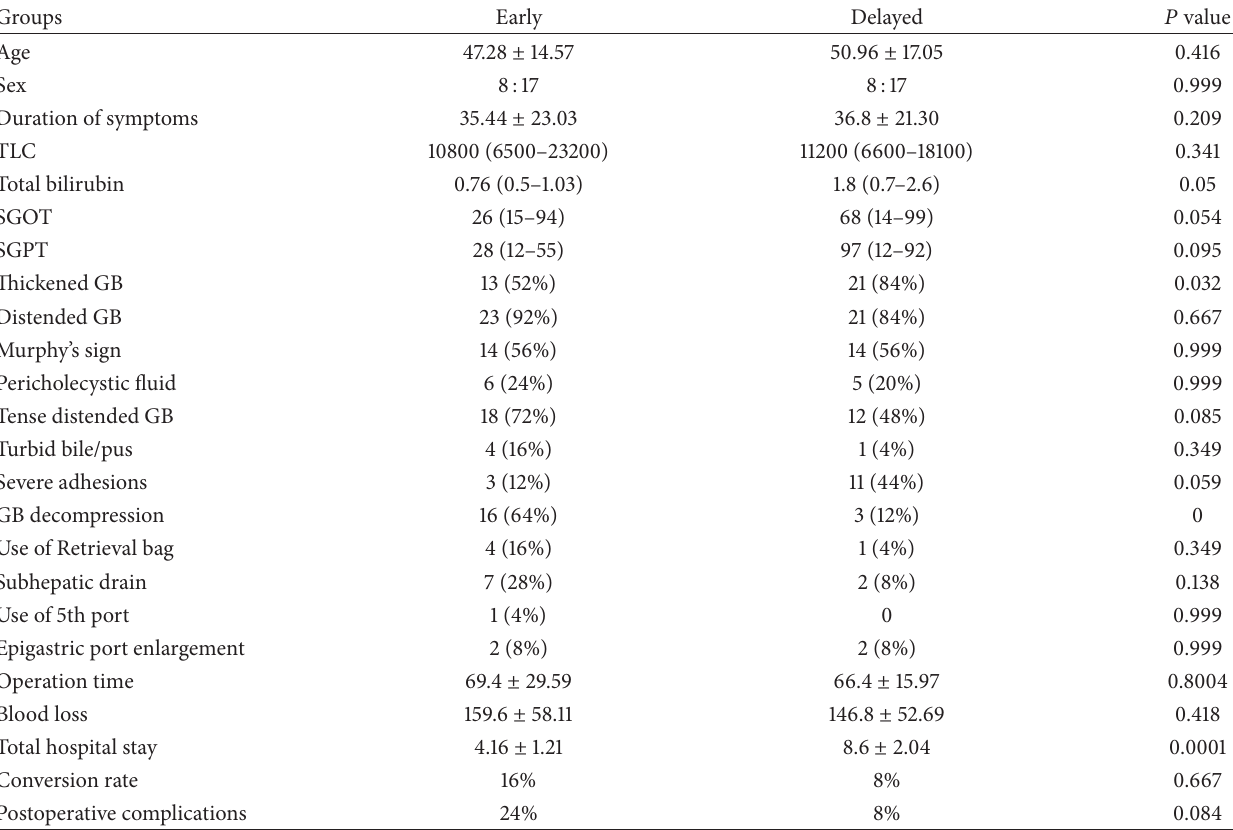
Table 6: Overall comparison of early and delayed